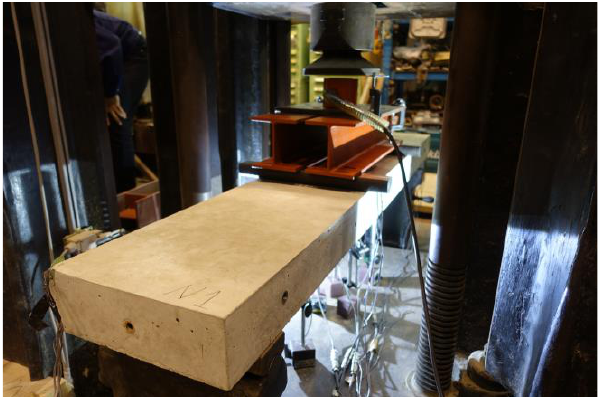
Figure 7. Set-up of a specimen.